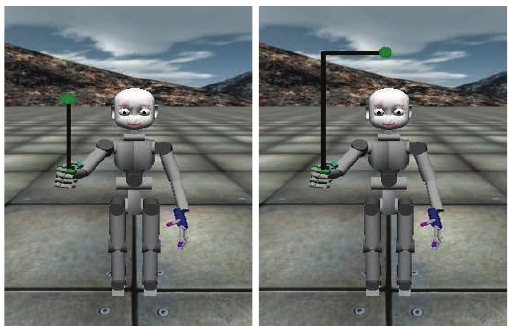
Figure 1. The humanoid robots iCub (on the left) and Kobian (on the right).